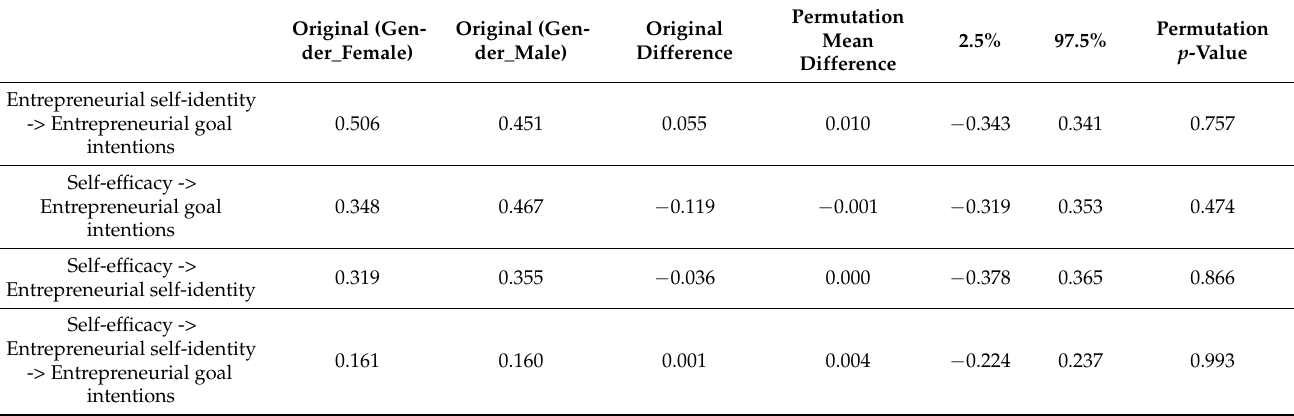
Table 7. Multigroup analysis path